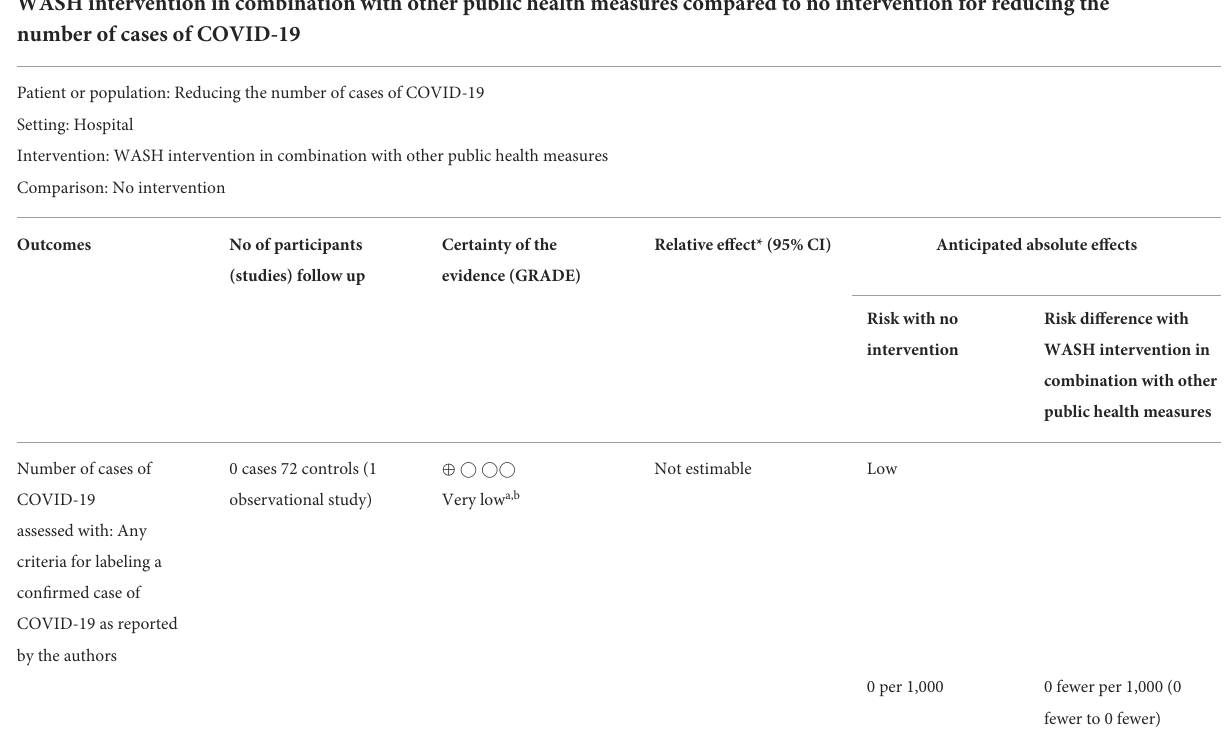
TABLE 1 Summary of findings for the primary outcome (Number of cases of COVID-19). WASH intervention in combination with other public health measures compared to no intervention for reducing